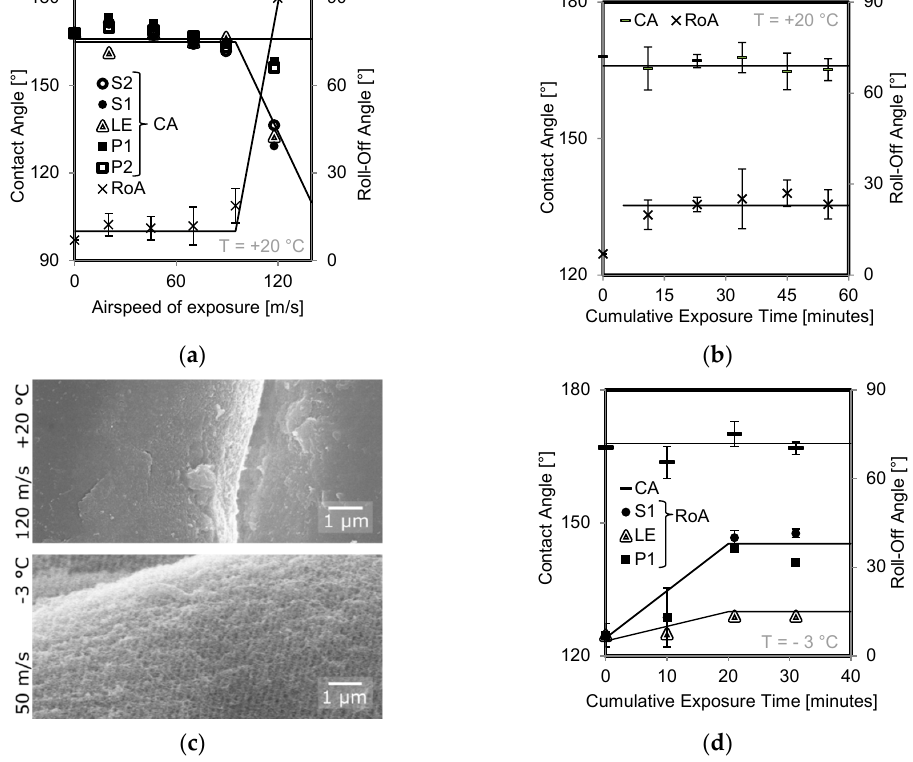
Figure 5. Wetting properties of the superamphiphobic fabric exposed to aerodynamic wear conditions. Pressure side “P2” (hollow square), pressure side “P1” (filled square), stagnation line “LE” (concentric triangles), suction side “S1” (filled circle), suction side “S2” (hollow circle) positions, equilibrium contact angle averaged over all positions (flat bar), and roll-off angle averaged over all positions (cross). ( a ) After exposure to a warm droplet cloud at speeds from 20 to 120 m/s, for a cumulative duration of 50 min. ( b ) After exposure to a warm droplet cloud at 90 m/s for up to 50 min. ( c ) SEM images of polyester fibers on fabrics exposed to 120 m/s (top) and 50 m/s for 3 icing cycles (bottom). ( d ) After exposure to 3 icing cycles at 50 m/s. Lines are shown as a guide for the eye.